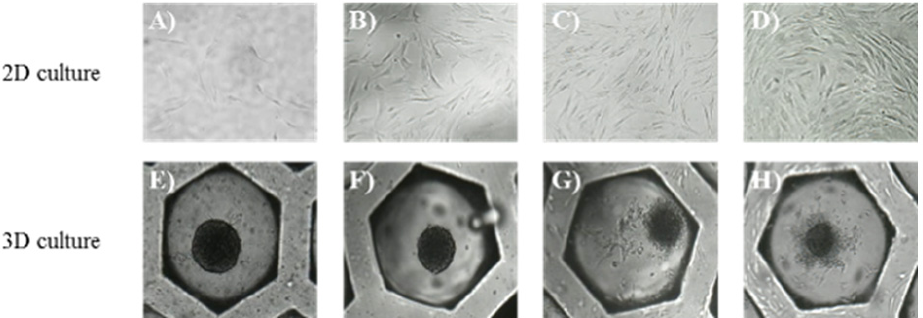
Figure 2. Morphology, days 1–7. ( A – D ) Morphology of sPDLSCs at days 1, 3, 5, and 7 in 2D cultures (magnification, × 200). The sPDLSCs increased in number over time. ( E – H ) Spheroid of sPDLSCs at days 1,3,5, and 7 in 3D cultures (magnification, × 200). The sPDLSCs aggregated and became spheroid for about 24h ( E ). Diameters of the spheroids decreased significantly over the time.